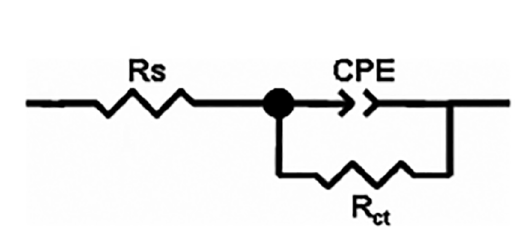
Figure 4. Equivalent circuit used to fit the EIS data.